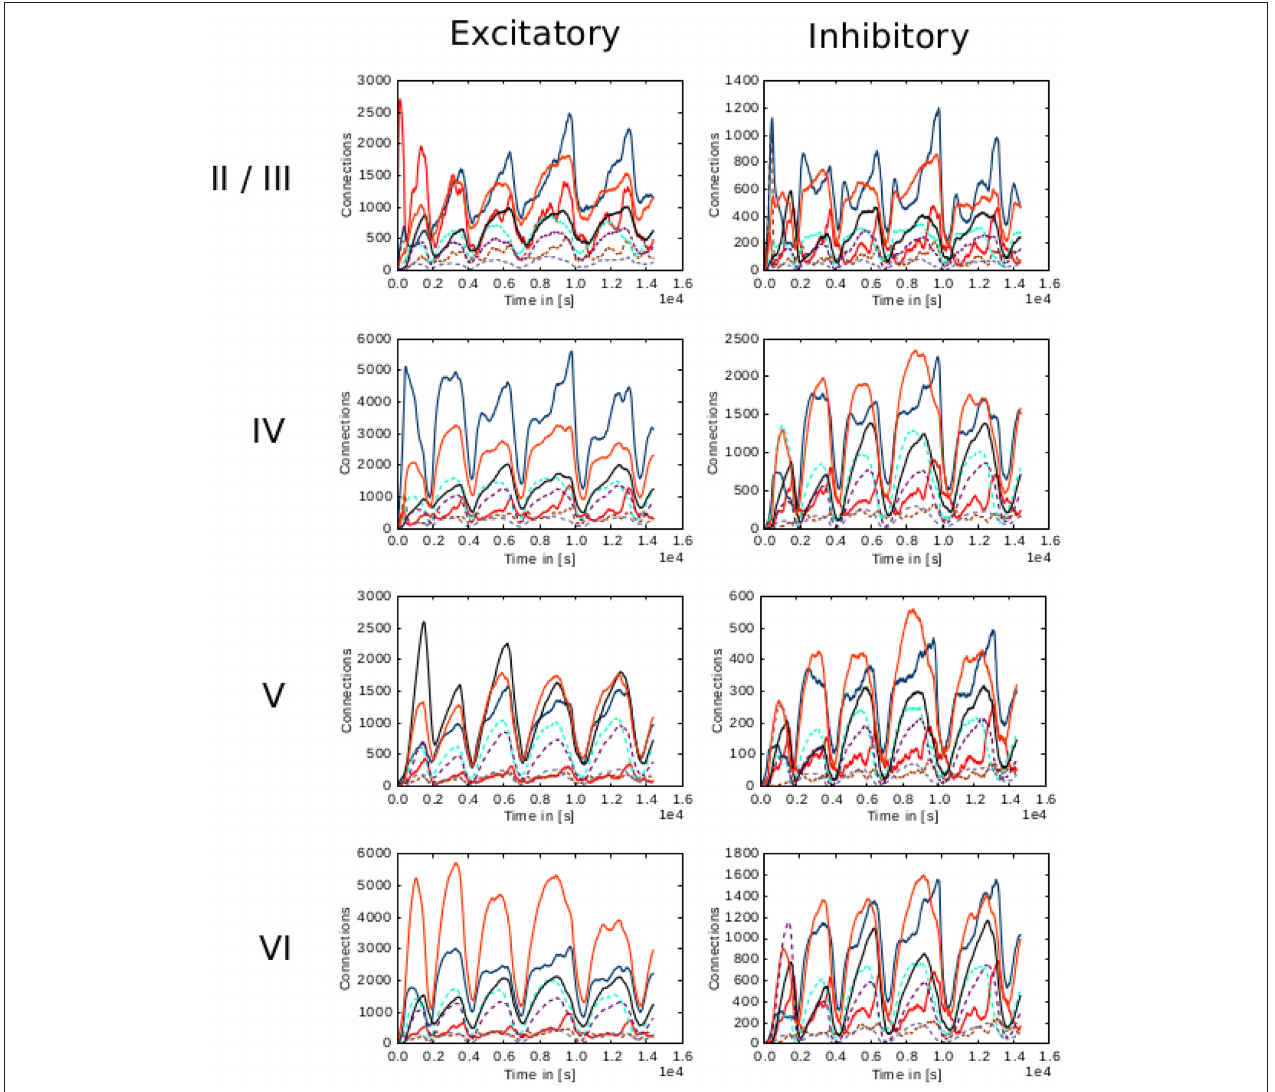
FIGURE 9 | Evolution of connectivity through time for each layer in the cortical microcircuit model with an unstable set of parameters. Panels on the left illustrate connections incoming from excitatory populations. On the right, connections incoming from inhibitory populations. Rows show connections incoming from layers II/III, IV, V, and VI from top to bottom, respectively. On every panel, connections to excitatory populations in layers II/III (red), IV (blue), V (black), and VI (orange) are shown as solid curves, and connections to inhibitory populations in layers II/III (brown), IV (cyan), V (gray), and VI (purple) are shown as dashed